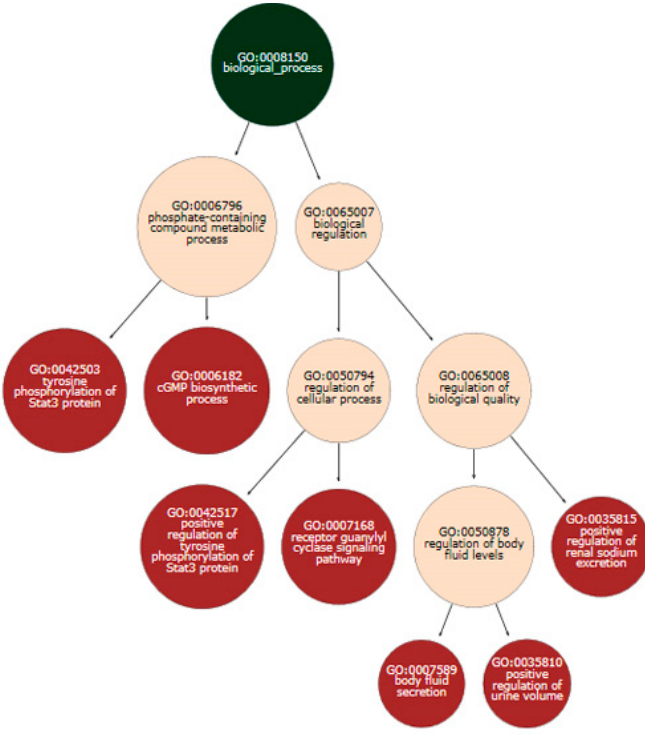
Figure 4. SRP127667: differentially expressed genes mapped onto Gene Ontology using BioInfoMiner.